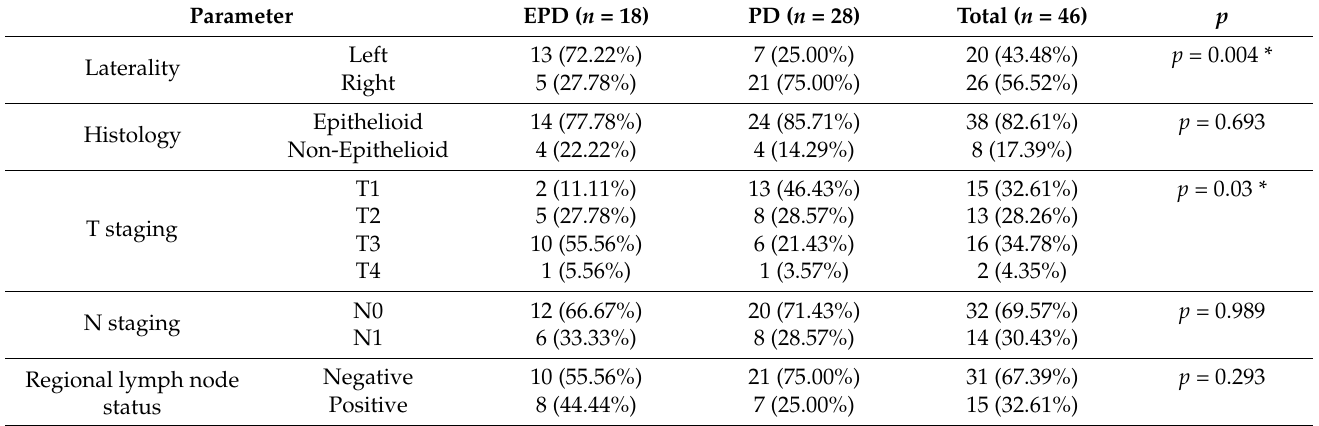
Table 2. Histopathology of Malignant Pleural Mesothelioma using the eighth edition of the TNM staging system. EPD indicates extended pleurectomy/decortication; PD, pleurectomy/decortication.